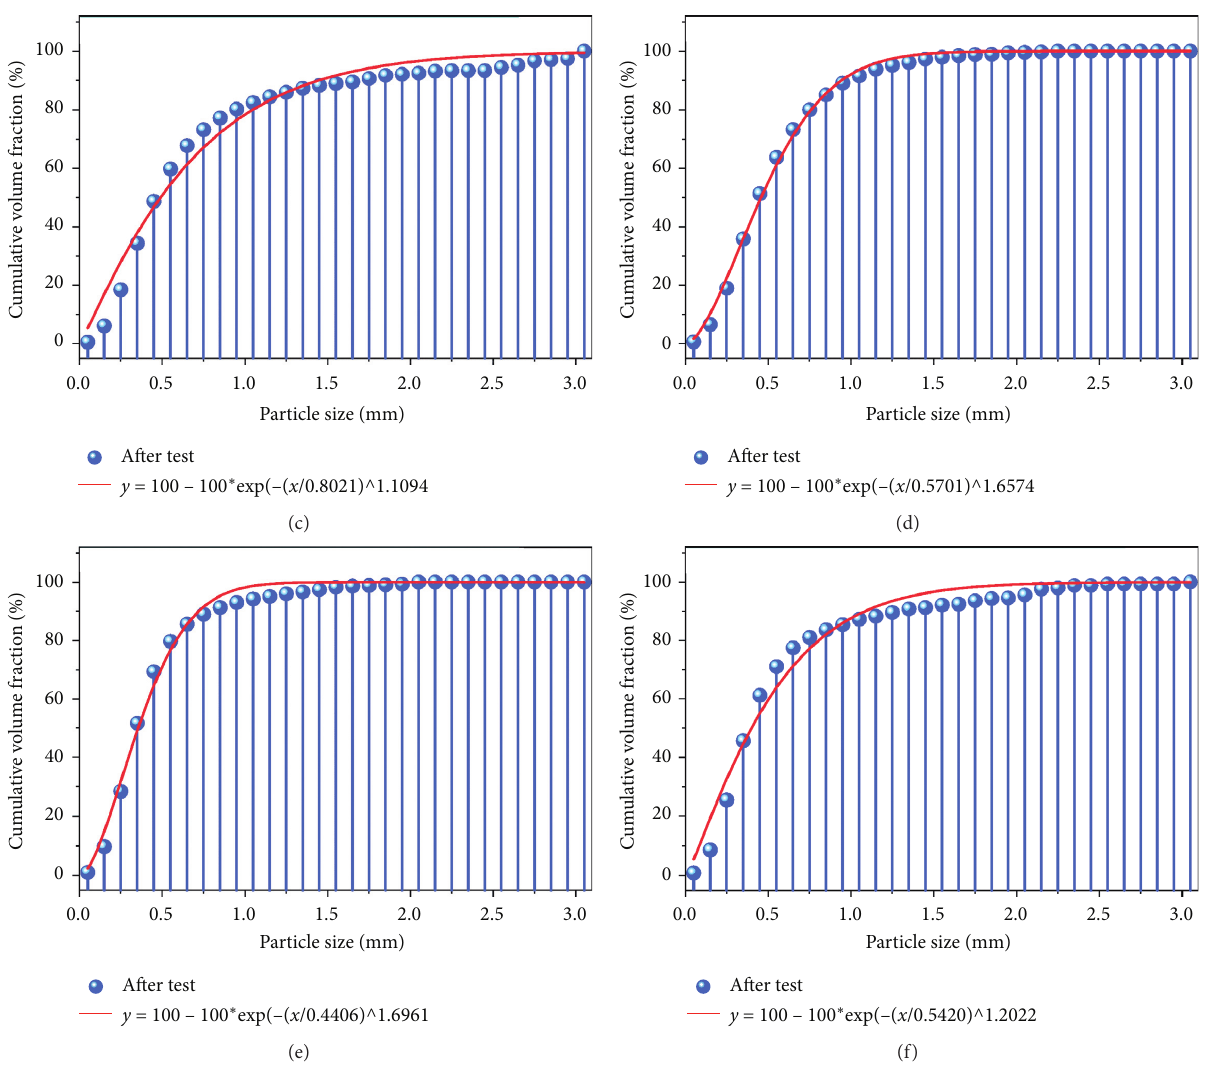
Figure 12: The cumulative distribution of particle size after the tests of single particle coal sample. (a) Original size: 1 − 3mm. (b) Original size: 3-4mm. (c) Original size: 4-5 mm. (d) Original size: 5-6 mm. (e) Original size: 6-7 mm. (f) Original size: 7-8mm.